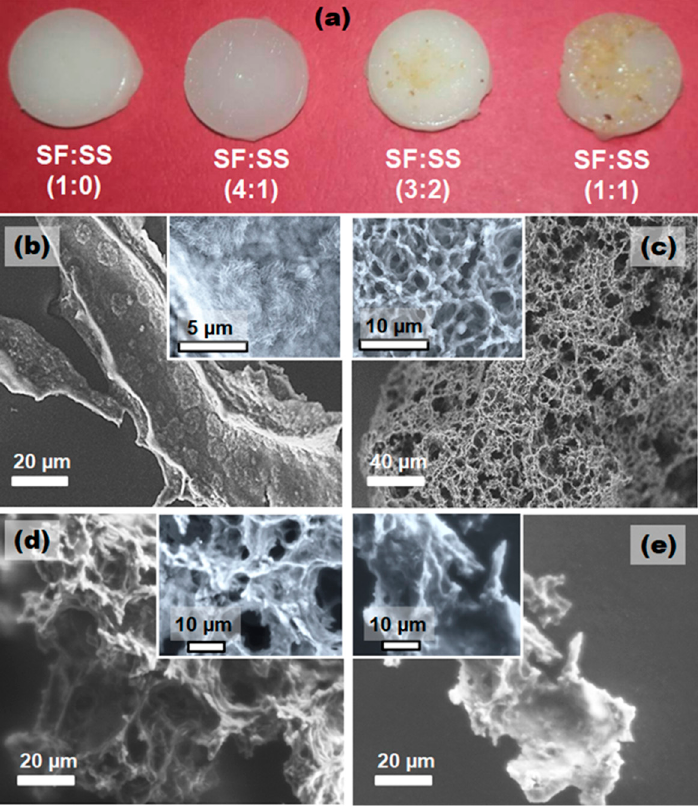
Figure 1. ( a ) Photograph of various SF:SS composites. SEM images of SF:SS composites with increasing SS fraction, i.e., SS:SS ratio of ( b ) (1:0), ( c ) (4:1), ( d ) (3:2), and ( e ) (1:1). Inset of figures ( b – e ) reflects the corresponding enlarged microstructure to highlight the pore structure.